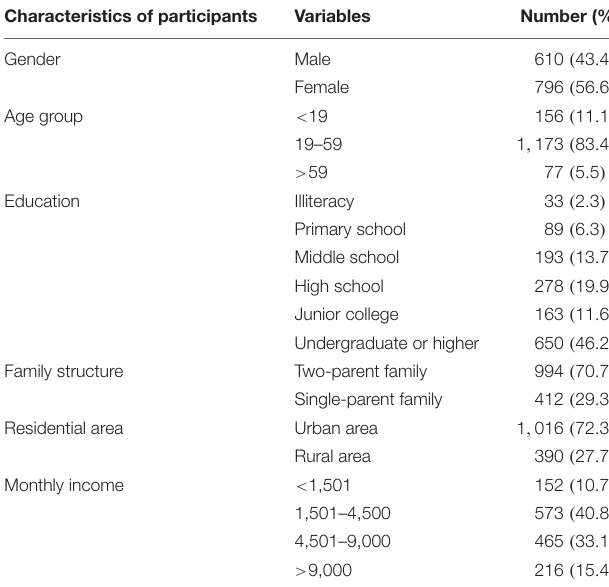
TABLE 1 | Sample characteristics ( N =